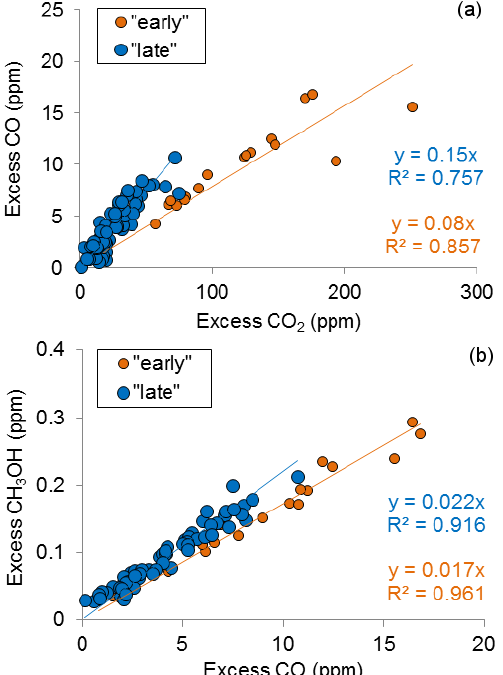
Fig. 4. ER plots of (a) 1 CO/ 1 CO 2 and (b) 1 CH 3 OH/ 1 CO from the Block 6 (30 October) fire with two trend-lines shown: samples collected “early” in the fire are shown as orange circles and those collected “late” in the fire are shown as blue circles. Different trends observed “early” and “late” in the fire’s progression imply changes in the sampled smoke over time and a decrease in